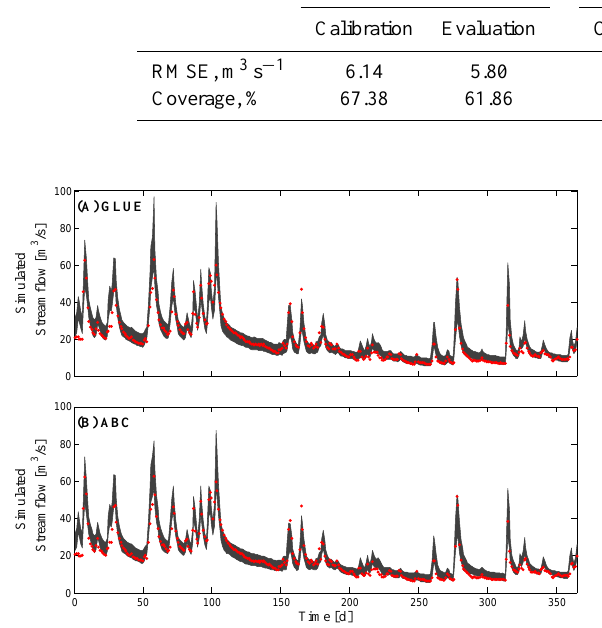
Fig. 6. SAC-SMA derived 95% streamflow simulation uncertainty ranges (grey region) of the calibration period of the French Broad river basin using (A) GLUE and (B) ABC. The observed discharge data are indicated with the solid red dots. We limit our display to the first 365-days of the calibration data set to simplify graphical interpretation. The simulation uncertainty ranges appear very simi- lar and nicely cover the observed discharge data.